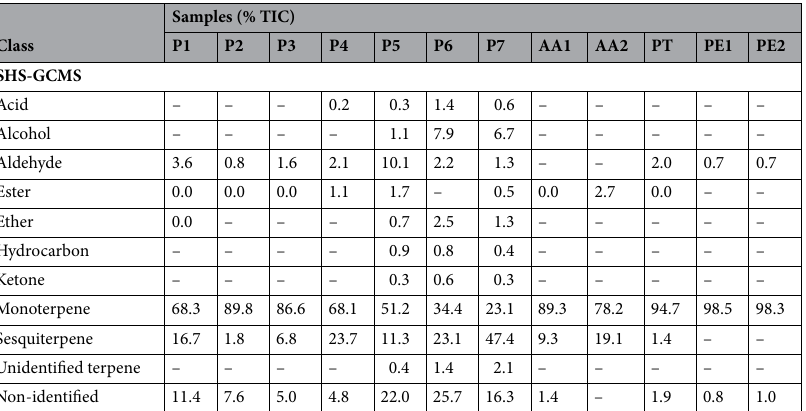
Table 2. Classes of volatiles obtained by SHS-GCMS in brown propolis and conifer resins from southern Brazil. – : Not detected or < 0.00. P1: Propolis from the ‘Dois tanques’ apiary in General Carneiro municipality, P2 and P3: Propolis from the ‘Beira do mato’ apiary in General Carneiro municipality. P4 and P5: Propolis from the ‘Vila Zulmira sede’ apiary in União da Vitória municipality. P6 and P7: Propolis from the ‘Vila Zulmira serra’ apiary in União da Vitória municipality. AA: Araucaria angustifolia resins. PT: Pinus taeda resins. PE: Pinus elliott